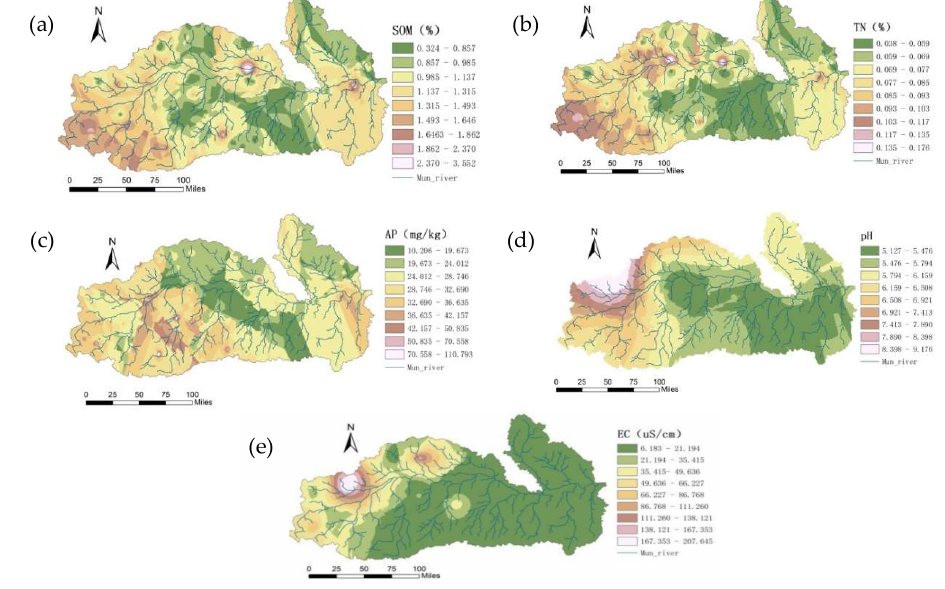
Figure 8. Spatial patterns of SOM ( a ), TN ( b ), AP ( c ), pH ( d ), and EC ( e ) in the rainy season. The spatial pattern of SOM was similar to that in the dry season, and SOM was relatively stable within a year. The SOM content in the upper and lower reaches was at medium and high levels, whereas that in the middle reaches of the region was at a low